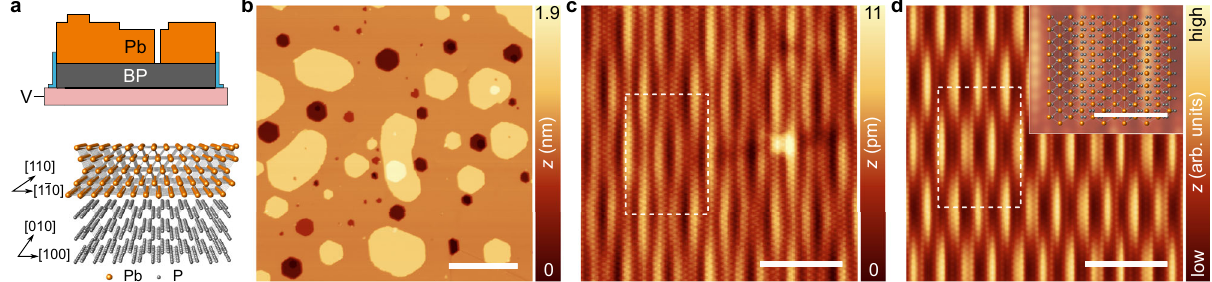
Fig. 1 Hybrid superconducting heterostructure of lead and black phosphorus. a Top: Sketch of the sample geometry showing the cross section of the ultra-thin Pb(111) fi lm and the BP crystal. The blue patches on the two sides represent side contacts. Bottom: Crystal structure of Pb and BP showing the relative orientation between the Pb lattice and the BP lattice. b Constant-current STM image of a 9 ML Pb fi lm ( V s = 600mV, I t = 10 pA, T = 1.3 K, scale bar = 50 nm). c Atomically resolved constant-current STM image measured on a 7 ML Pb fi lm showing the persistent moiré structure between Pb and BP. The white dashed rectangle represents moiré supercell. ( V s = 100 mV, I t = 100 pA, T = 30 mK, scale bar = 5 nm). d Simulated moiré structure as described in Supplementary Note 1. The white dashed rectangle represents moiré supercell (scale bar = 5 nm). Inset: lattice structure of the interface overlayed on the zoomed-in image of the simulated moiré structure (inset scale bar = 2